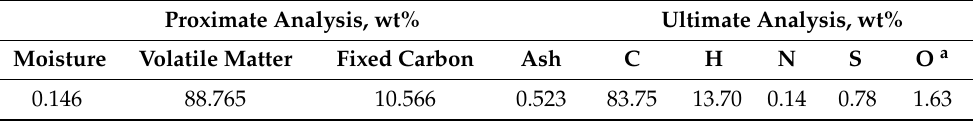
Table 3. Some characteristics of the PVC samples.